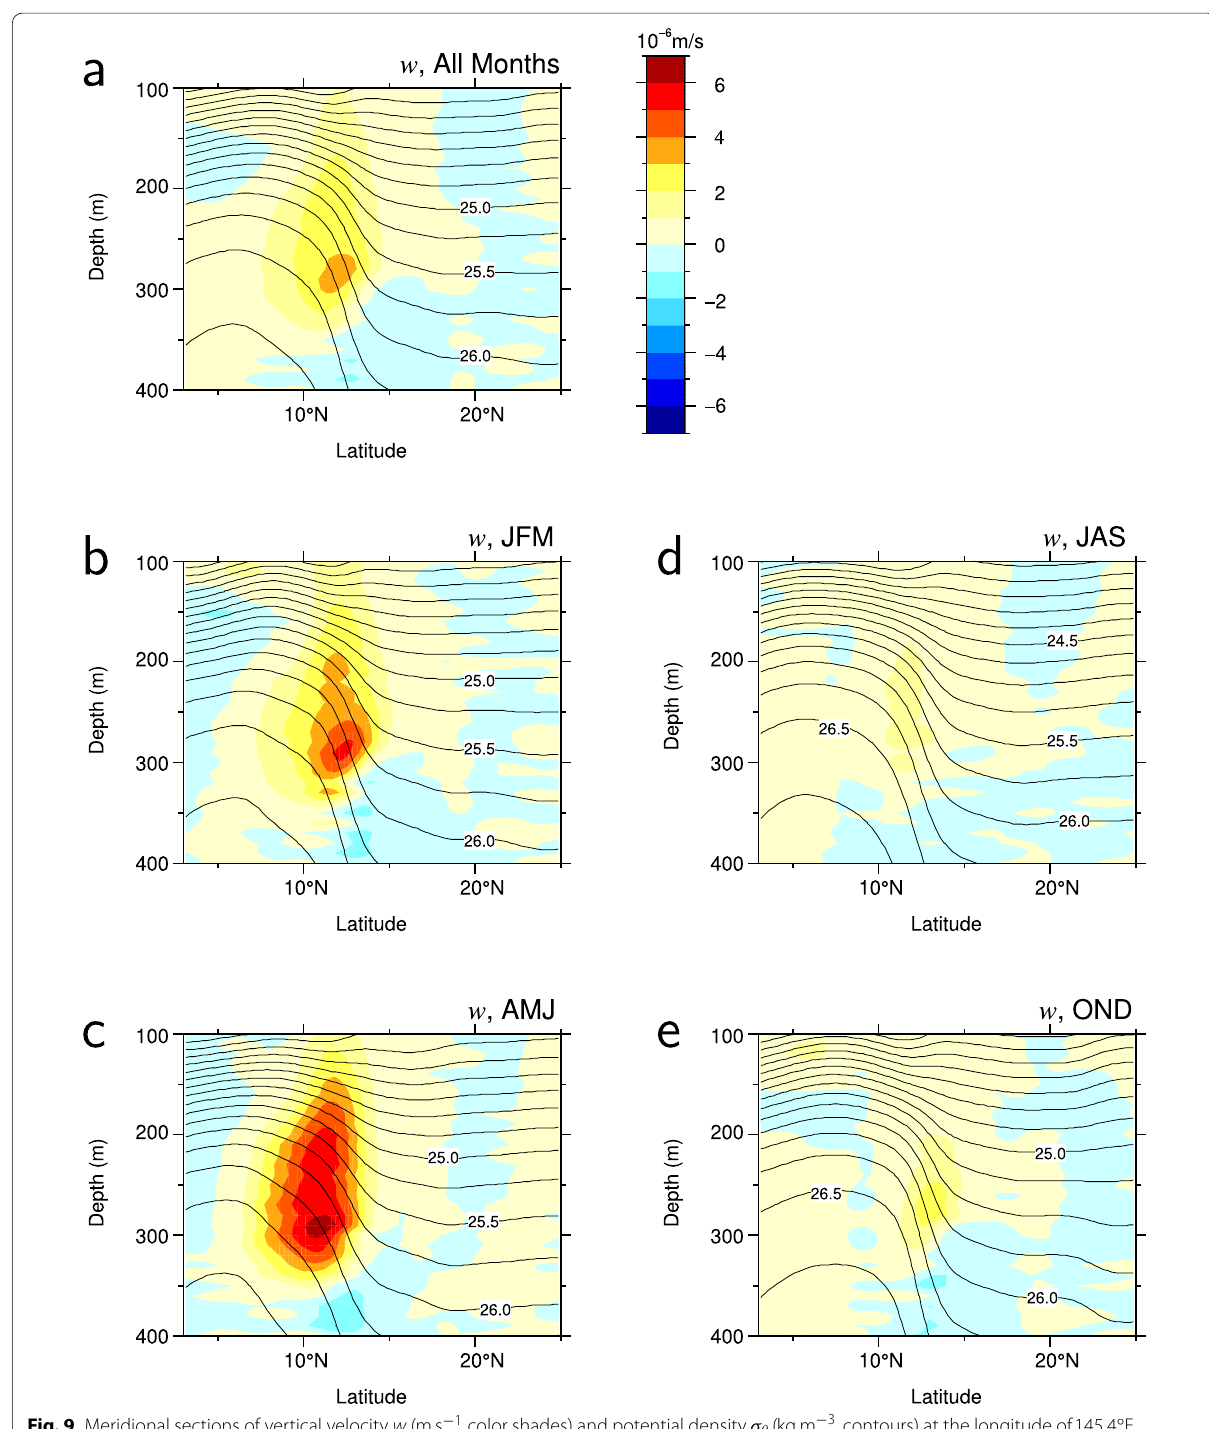
Fig. 9 Meridional sections of vertical velocity w ( ms − 1 , color shades) and potential density σ θ ( kgm − 3 , contours) at the longitude of 145.4 ◦ E averaged in a all months, b January–March, c April–June, d July–September, and e October–December during 1993–2016. Positive values show upward velocity. Contour intervals of σ θ are 0.25 kgm −